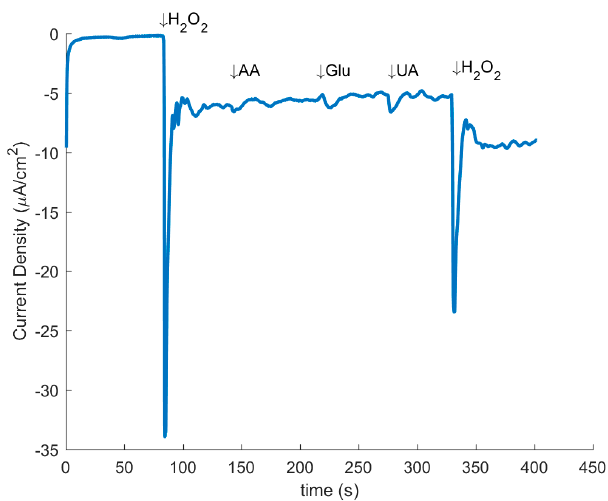
Figure 7. Amperometric response of the Mechanically Treated CNF at a potential of − 0.5 V vs. Ag/AgCl with addition of interfering agents (1 mM H 2 O 2 , 0.15 mM AA, 1 mM Glu, 0.5 mM UA, and 1 mM H 2 O 2 ).